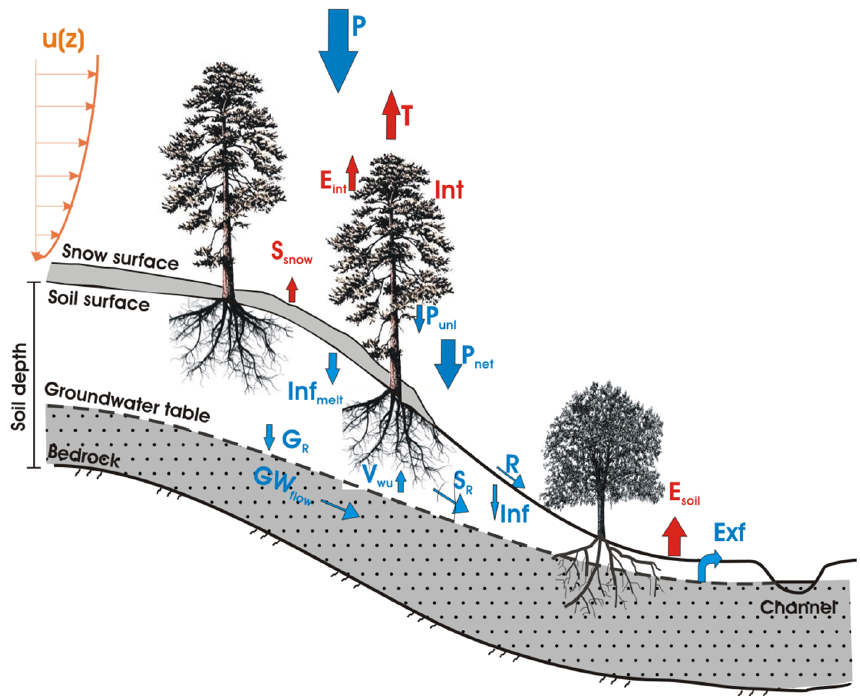
Figure 1. Elements of the water balance in a forested hillslope: A fraction of the gross precipitation or snow ( P ) is intercepted by vegetation (Int) and the remaining volume reaches the ground as net precipitation or snow ( P net ). Intercepted water (Int) is either unloaded from leaves and branches ( P unl ) or temporarily stored for evaporation ( E int ) back to the atmosphere. If snow occurs, P net builds up snowpack. When thermodynamic conditions allow, retained water in the snow can sublimate ( S snow ), or after melting, it can infiltrate (Inf melt ), runoff ( R ) or be transpired by plants ( T ), evaporated from soil ( E soil ), serve as groundwater recharge ( G R ) or remain as soil moisture in the vadose zone. Analogously, if only liquid precipitation occurs, P net redistributes according to the processes mentioned above, except for the snow-related mechanisms. Runoff ( R ) can be produced through infiltration excess, saturation excess, perched return flow and/or groundwater contribution (Exf). Subsurface flow can occur through lateral vadose zone flow ( S R ) and/or groundwater flow (GW flow ). An aerodynamic component has been added to this plot to mark the importance of the surface roughness by trees on evaporation and sublimation water